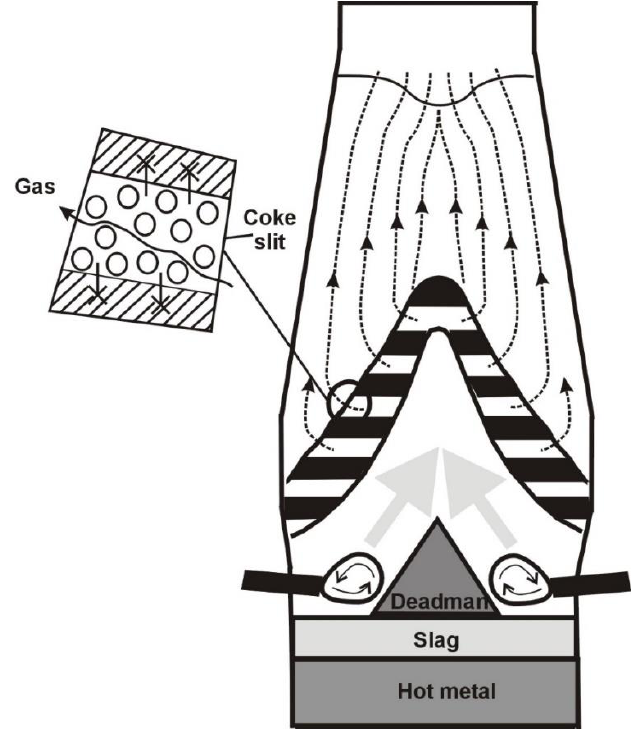
Figure 1. Permeability of cohesive zone in a blast furnace.